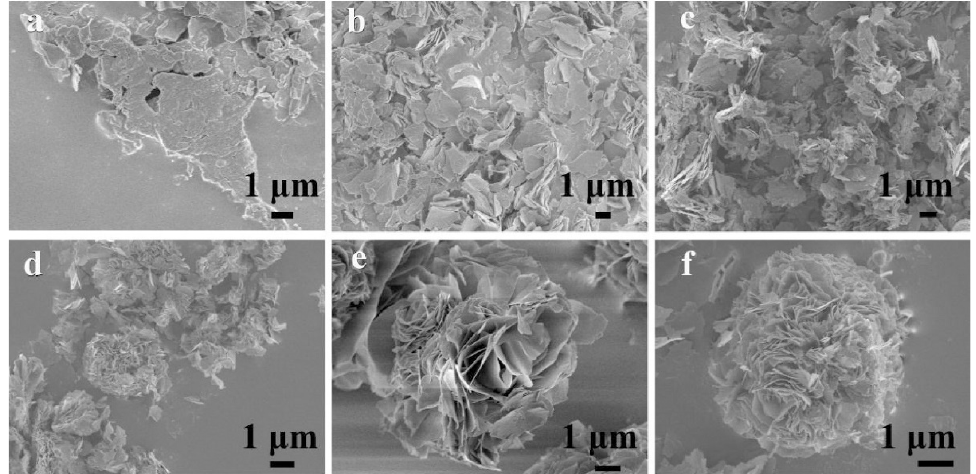
Figure 9. SEM images of ZnCo-preprepared with different reaction times: ( a ) 4 h, ( b ) 6 h, ( c ) 12 h, ( d ) 18 h, ( e ) 21 h, and ( f ) 24 h. Reproduced with permission from Liangyu Shang, Self-assembled hierarchical peony-like ZnCo 2 O 4 for high-performance asymmetric supercapacitors; published by Elsevier, 2017 [135].